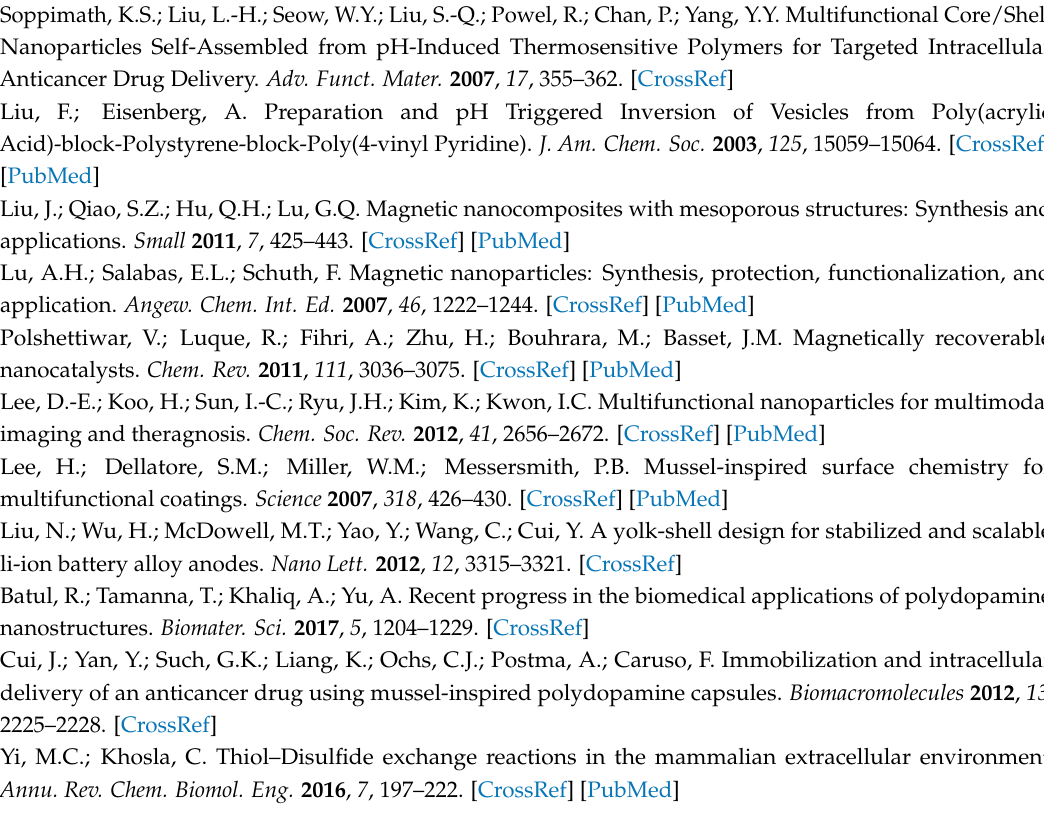
Figure S1: XRD pattern of the bare IONPs ( λ = 1.540598 Å), Figure S2: SAED patterns obtained via TEM analyses of A. bare IONPs and B. pDA-IONPs, Figure S3: Suspension images of (A). pDA-IONPs and (B). GSSG-pDA–IONPs after 24 h in PBS (10 mM, pH 7.4), Figure S4: Calibration curve showing the magnetic susceptibility vs. concentration of bare IONPs. Measurements were carried out in deionized water at pH 5.0–6.0, Figure S5: FTIR spectrum of the prepared DTX-PMPI, Figure S6: 1H-NMR predicted spectrum of DTX-PMPI, Figure S7: DLS size measurements to check the colloidal stability of the developed nanoparticles drug loaded FDG (GSH-pDA-SPIONs) in biological media (RPMI and albumin in NaCl) at 37 ◦ C, Figure S8: Confocal images of PC3 cell lines with A. no treatment, B. only DOX and C. DOX loaded nanoparticles; Table S1: Comparative chart showing the drug loading efficiencies of doxorubicin and docetaxel, calculated using different